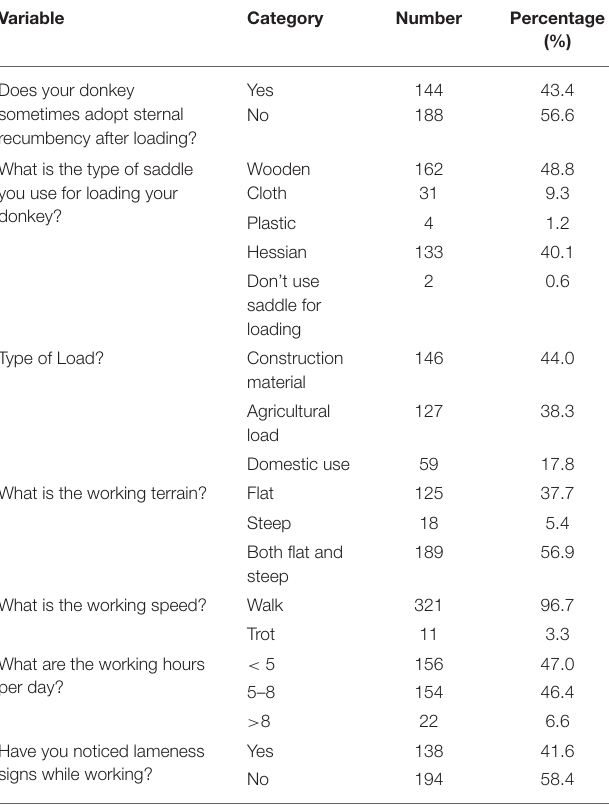
TABLE 2 | Practices of working donkey owners related to mounted load